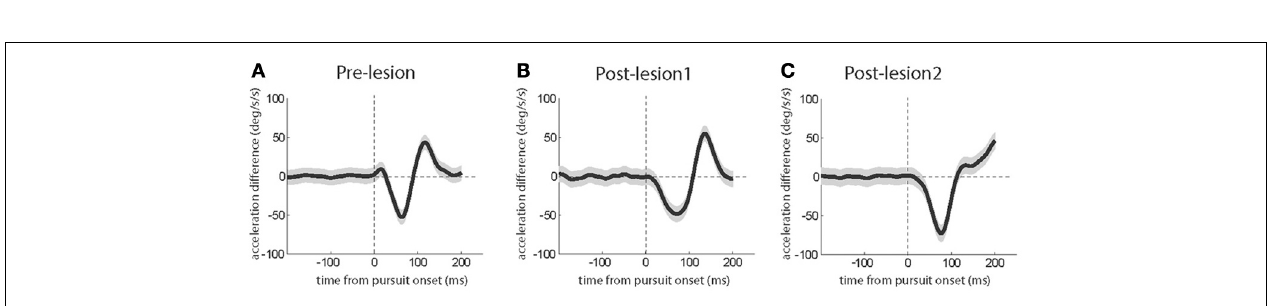
the standard error. The lower row panels (G–I) depict the periods when the acceleration profiles [blue and red; (D–F) ] were significantly different from each other based on a running paired t -test. The red horizontal line indicates a p -value of 0.05. The dashed vertical (black) line marks pursuit onset and the red vertical lines show the time points when the significance level crossed the p -value of 0.05.